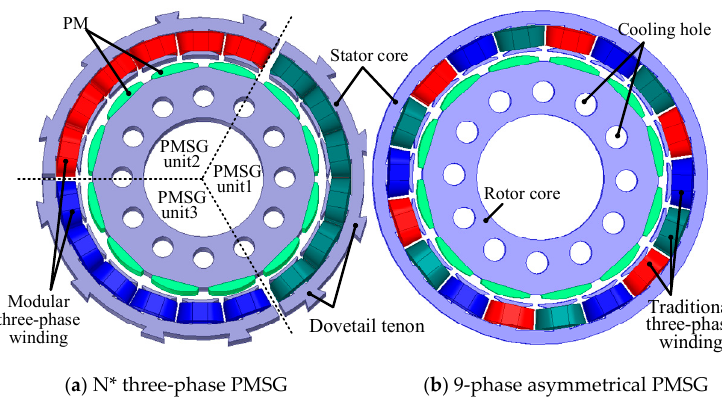
Figure 2. Structural sketch of N* three-PMSG (N = 3) and 9-phase asymmetrical PMSG.